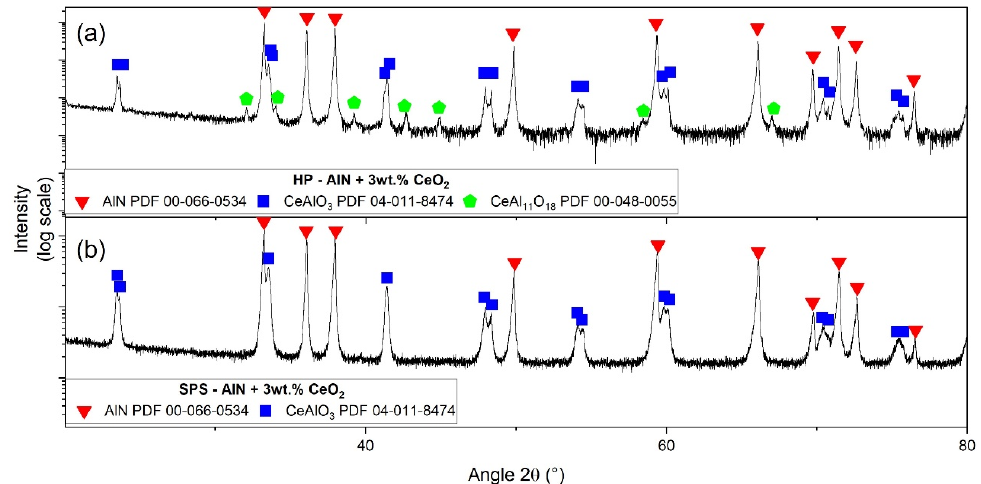
Figure 12. X-ray diffraction patterns of AlN + 3 wt.% of cerium oxide obtained by ( a ) HP and ( b ) SPS.